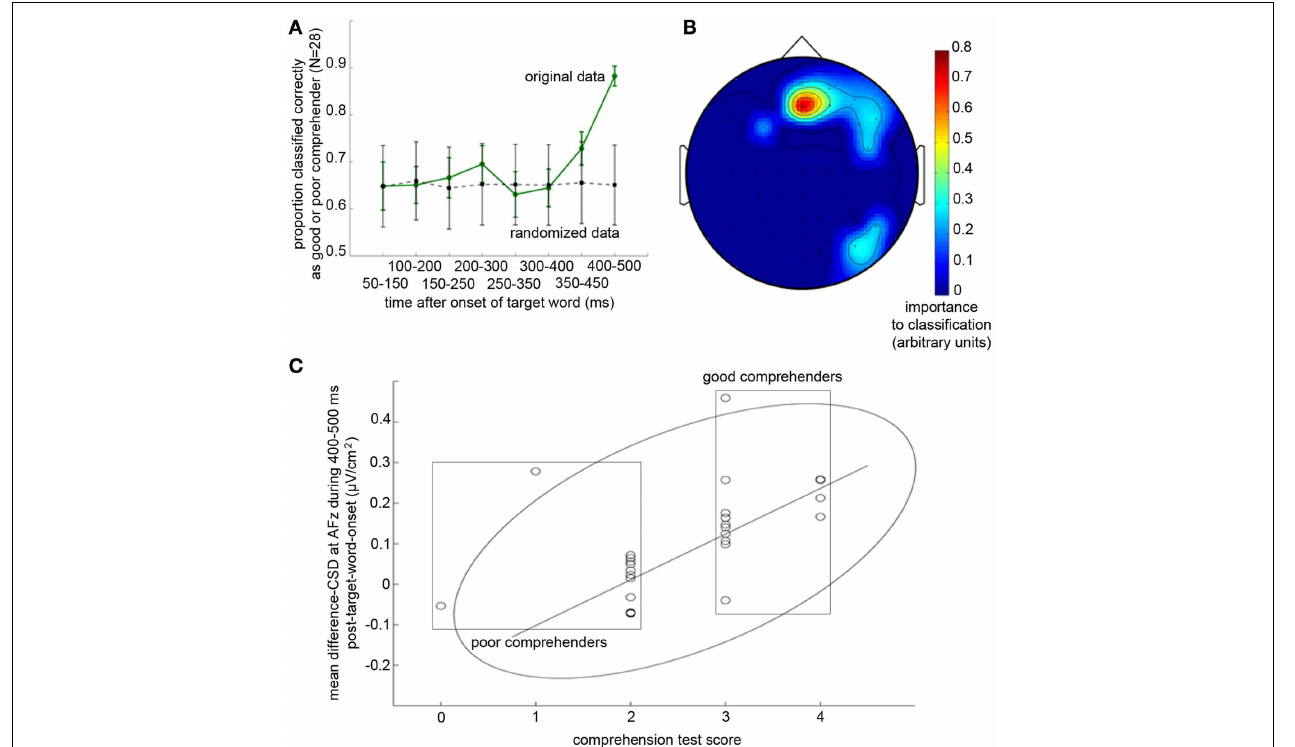
FIGURE 5 | Temporal and spatial profiles of difference-CSDs (CSD-transformed ERPs in the scrambled condition minus those in the comprehension condition) that predict individual differences in reading comprehension performance. (A) Proportion of successful classification of participants into good and poor comprehenders based on difference-CSDs from eight overlapping 100-ms time bins. Solid green line shows the mean of 1000 classification results using the original data, and dotted gray line shows the mean of 1000 control classification results using the same data but with randomized labeling of good and poor comprehenders (see Methods). Error bars represent ± 1 SD (standard deviation). It is apparent that the